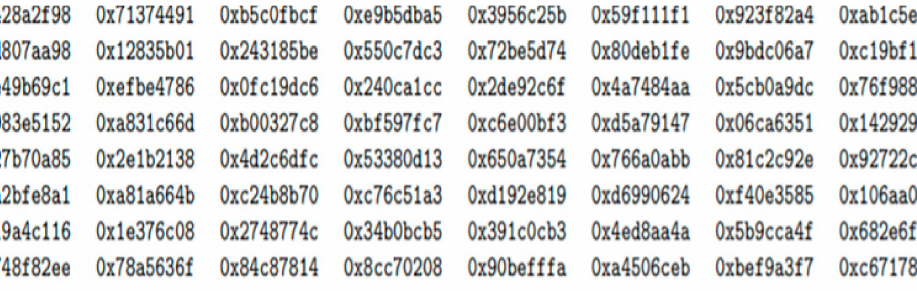
Figure 9. Generated constants that are the keys to the hashing